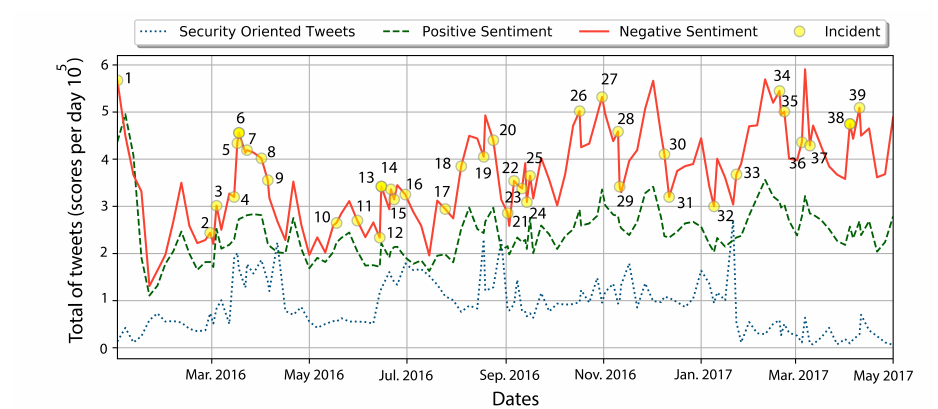
Figure 6. Chronological user’s sentiments and reported security-related